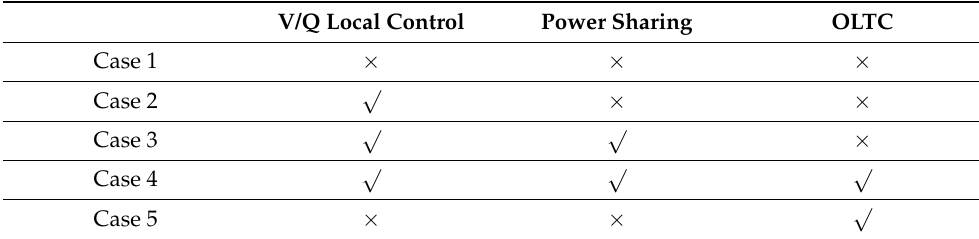
Table 3. Simulation Case